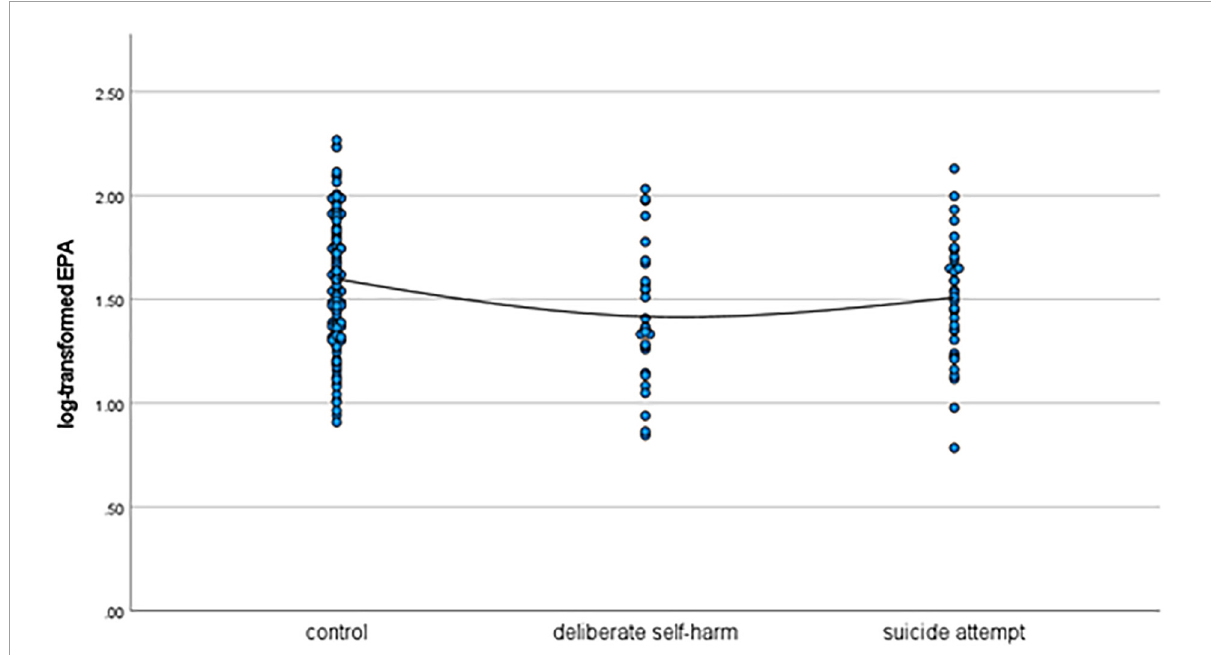
FIGURE3 Scattergram of log-transformed DHA levels in the control, deliberate self-harm, and suicide-attempt groups.